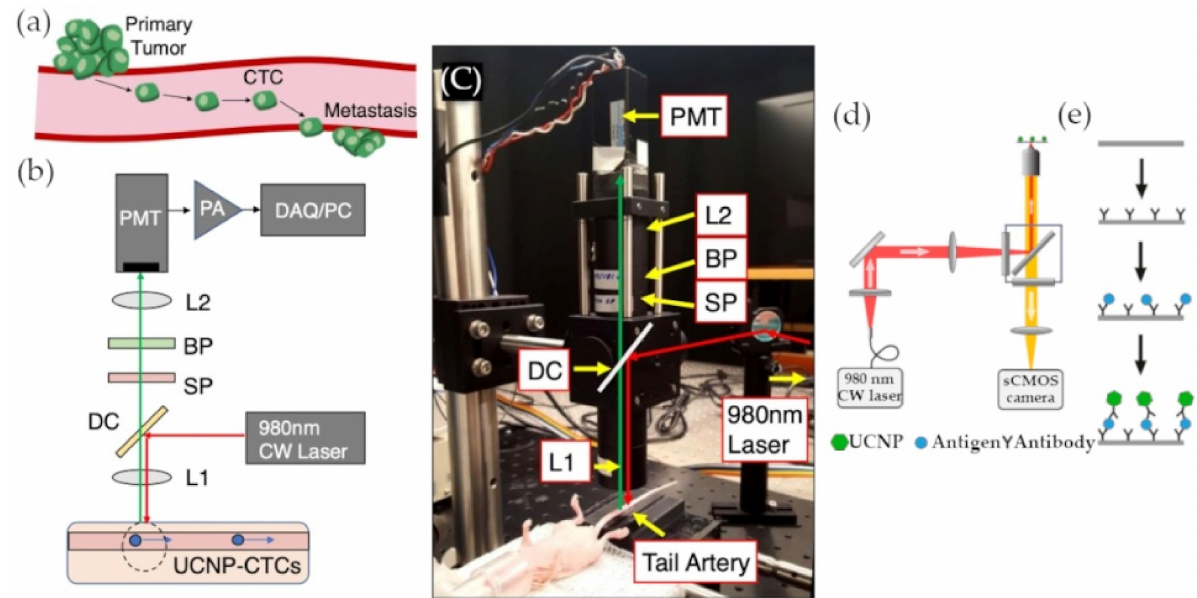
Figure 6. Upconversion nanoparticle (UCNP) detection settings. ( a ) Schematic of primary tumor metastasis; ( b ) schematic of in vivo CTCs detection by diffuse in vivo flow cytometry (U-DiFC); ( c ) photograph of U-DiFC setting; ( d ) schematic of in vitro circulating cancer biomarker detection setting; ( e ) schematic of UCNP sandwich immunoassay. (Reproduced with permission from [52], published by Dove Medical Press Limited 2020; reproduced with permission from [53], published by American Chemical Society